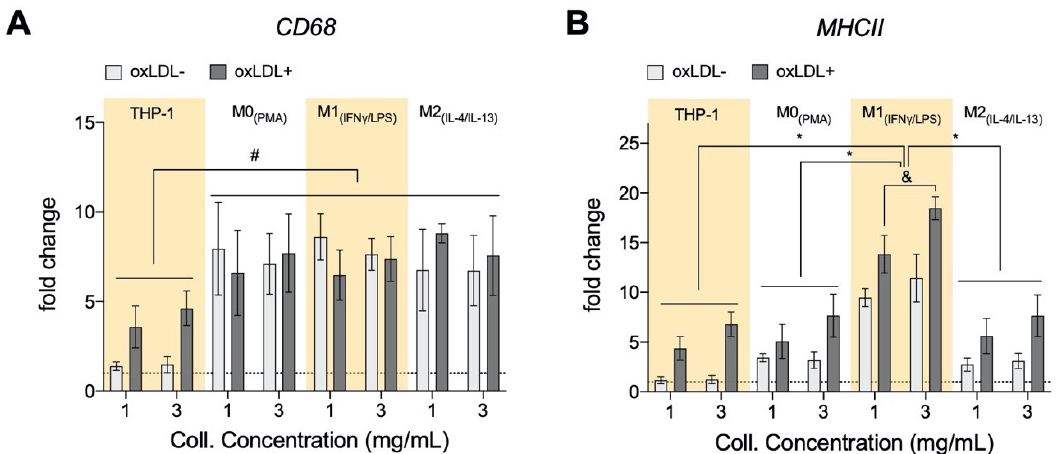
Figure 6. Expression of selected markers of monocytes and macrophages cultured in 3D collagen hydrogels. ( A ) For all cell types, the pan-macrophage marker (CD68) was also increased with the exposure to oxLDL, with THP-1 having the highest fold induction. ( B ) There was an increase in gene expression of the well-acknowledged activation maker (MHCII) in all cell types after exposure to oxLDL. There is also a general increase in expression with increment of collagen hydrogel density ( x -axis, 1 (1 mg / mL) → 3 (3 mg / mL)). This correlation of MHCII gene expression with tissue density is statistically significant for THP-1 and M1. All significances represented as p < 0.05, * compared to corresponding untreated and treated samples at the same matrix condition, and significant change with collagen concentration and # significant compared to untreated samples at the same matrix conditions. The dotted horizontal line indicates a level of no